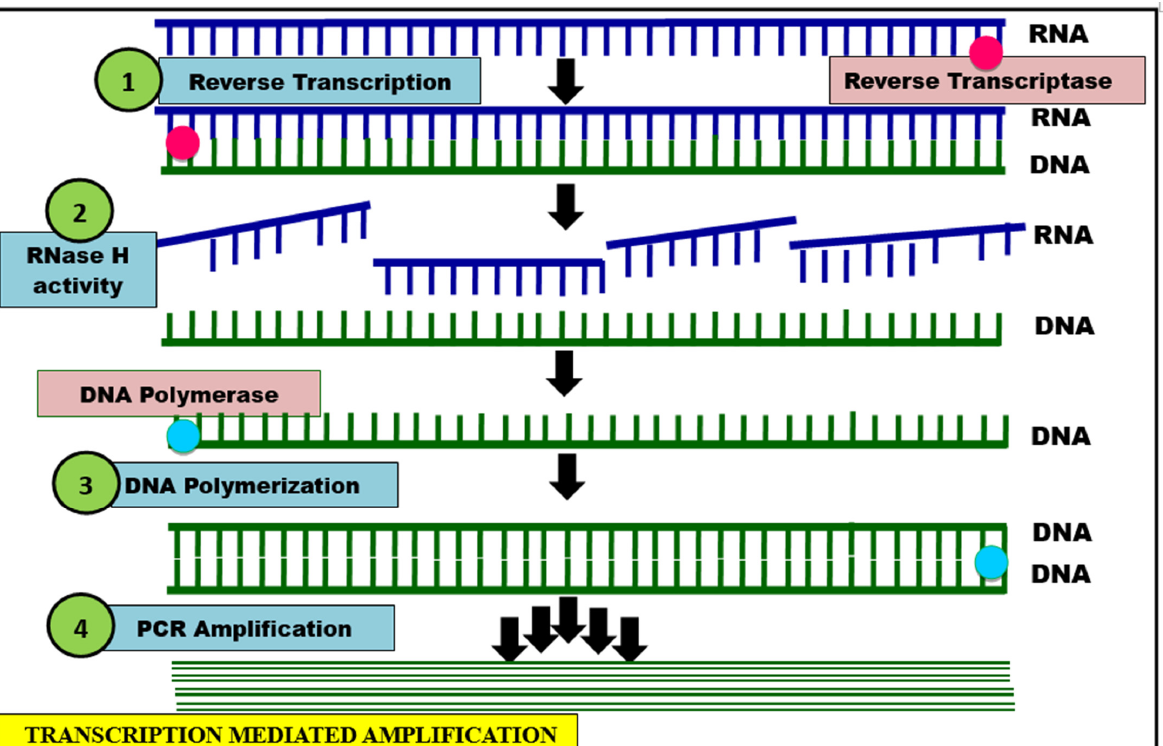
Figure 3. Transcription-mediated amplification (TMA)-based detection of SARS-CoV-2 infection:( 1 ) reverse transcription-based first-strand cDNA synthesis;( 2 ) RNA strand of hybrid RNA–cDNA is degraded by the RNase H activity of the enzyme reverse transcriptase;( 3 ) DNA polymerization for the synthesis of second-strand cDNA;( 4 ) PCR amplification with specific primers will demonstrate either positive or negative results for SARS-CoV-2 virus detection (multiple arrows indicate multi- ple cycles of amplification).